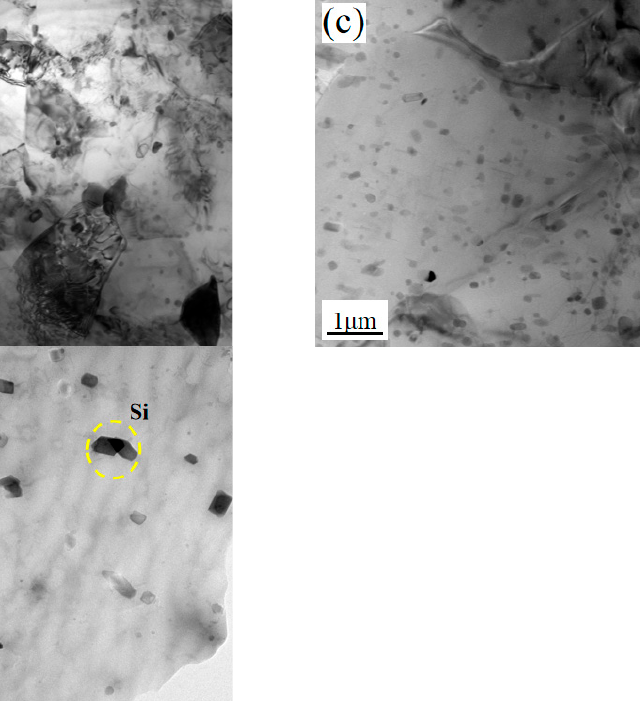
Figure 13. Shows the TEM microstructure of HRS-SFSP, and ( a – c ) are the grain and second phase distribution of SZ-1, SZ-2 and SZ-3, respectively; ( d ) HRTEM of Mg 2 Si and ( e ) BM.